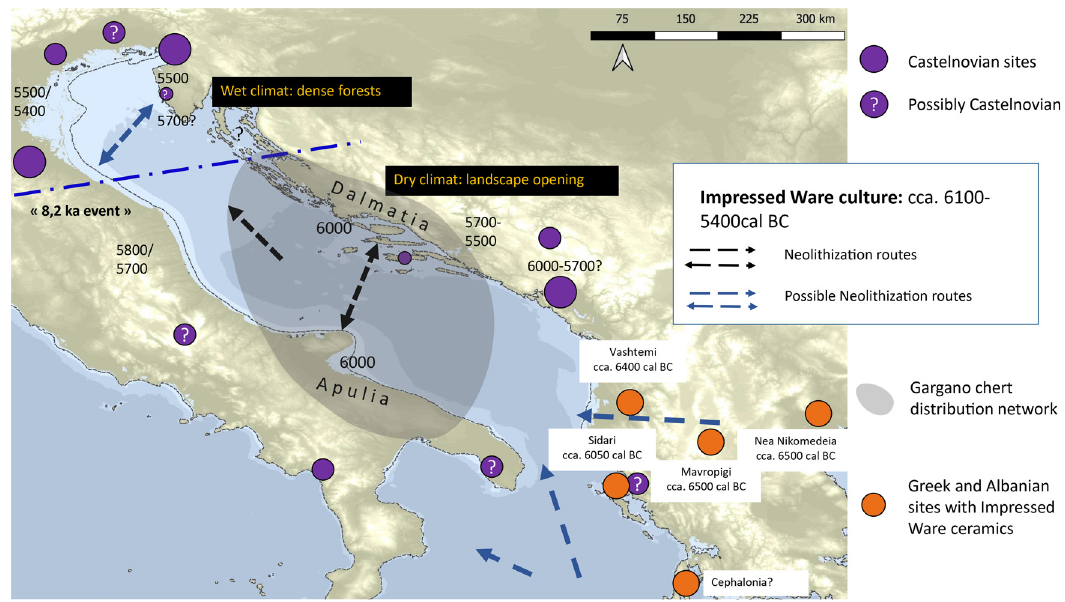
Figure 5: Proposed model for the Neolithisation of the Adriatic: the Gargano chert distribution network ( shaded surface ) corresponds to the epicentre of the Impressed Ware culture ( Apulia, Eastern Calabria, Northern Basilicata, and Dalmatia ) , while the regions outside the distribution area represent the margins of the Impressed Ware culture ( Istria and possibly Kvarner ) . The northern extension of the Gargano network is possibly linked to the border between the Italo - Dalmatian Impressed Ware and the Impressa medio - adriatica. The numbers ( 6000, 5800/5700 etc. ) correspond to the cal BC